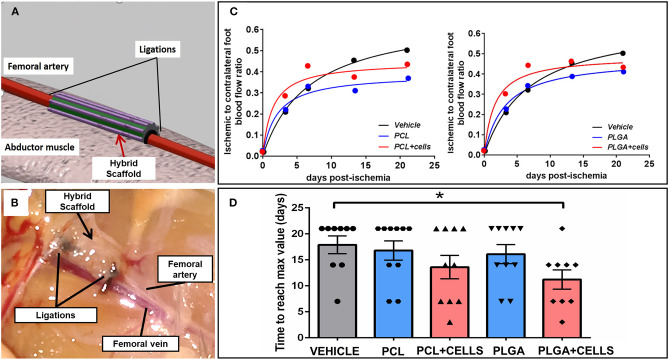
Outcomes of the in vivo implantation study. (A,B) Schematic representation (A) and photograph captured with optical microscopy of hybrid scaffold implantation (B); (C) Time course of blood flow recovery expressed as the ratio of ischemic and contralateral limb; (N = 9–10 per group); (D) Bar graph showing the velocity of blood flow recovery; data expressed as mean ± SE; N = 9–10 per group. Groups: (1) Vehicle: induction of unilateral limb ischemia (LI) without treatment; (2) PCL: induction of LI and implantation of PCL-GL + AG/PL without cells; (3) PCL + CELLS: induction of LI and implantation of PLC-GL + AG/PL with cells; (4) PLGA: induction of LI and implantation of PLGA-GL + AG/PL without cells; (5) PLGA + CELLS: induction of LI and implantation of PLGA-GL + AG/PL with cells. *p < 0.05 vs. vehicle.